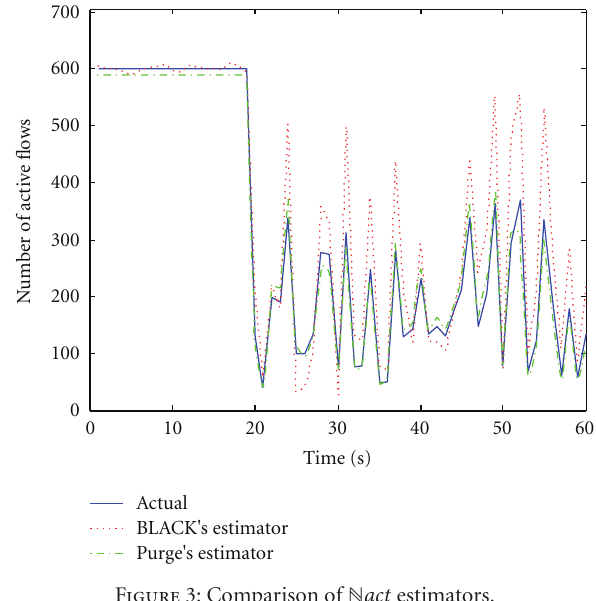
Figure 3: Comparison of N act estimators.